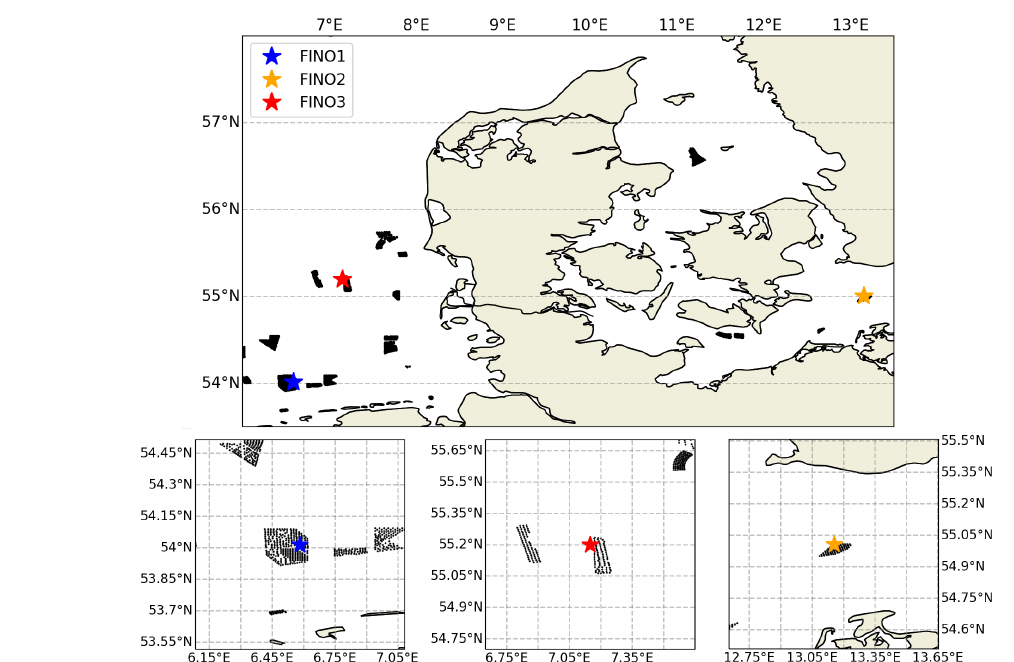
Figure 1. Map of the study area with the FINO mast locations in the North Sea and Baltic Sea (top). The black shapes represent nearby offshore wind farms. The bottom panels show close-ups for the met mast locations with black dots representing individual wind turbines. Table 1. Characteristics of FINO masts with the heights of available measurements for various meteorological and oceanographic parameters averaged in 30min